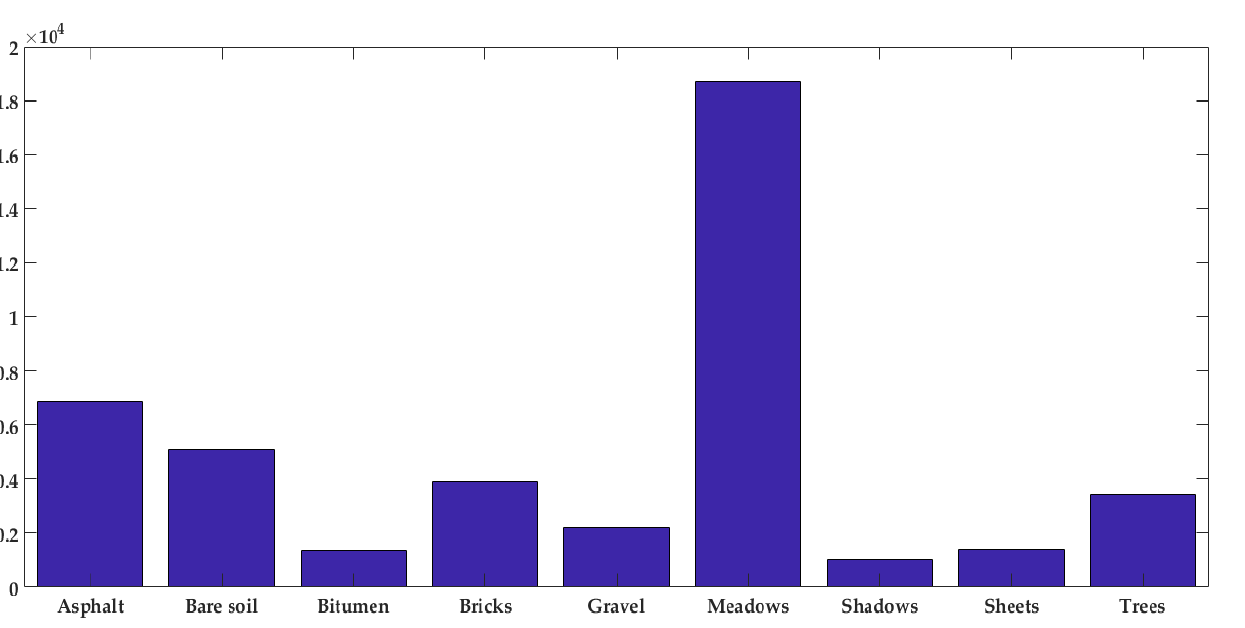
Figure 11. Class distribution in Pavia